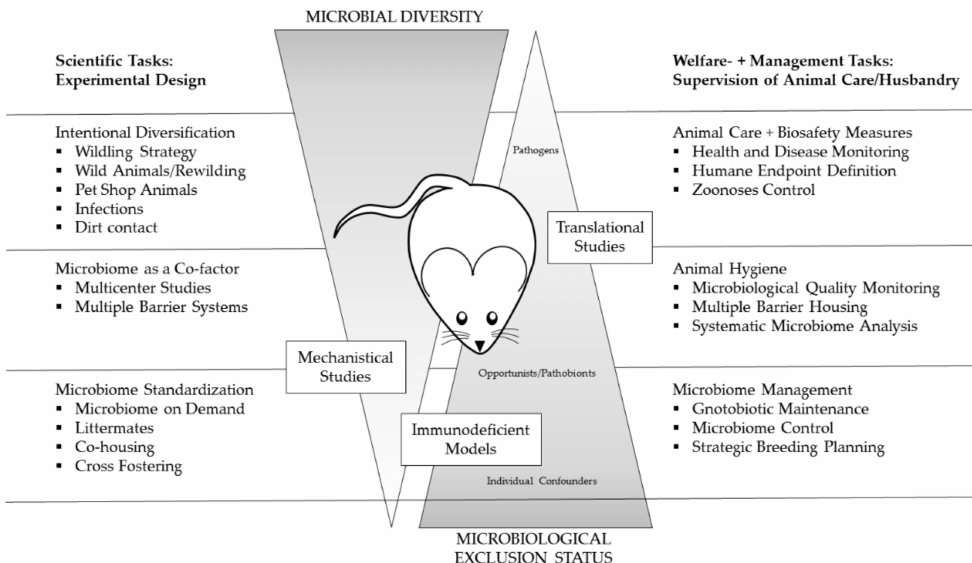
Figure 5. Dependencies of scientific strategies to cope with microbiome challenges, animal ´ s hygiene status as well as welfare and management tasks. The primarily scientific tasks regarding study design (depicted on the left-hand side) have enormous implications on the scope of hygienic management and health monitoring as well as on the veterinary care and colony management (depicted on the right hand side). Depending on the study planned, the microbial diversity and microbiological exclusion status have to match the requirements of the different animal models to ensure both scientific value and animal welfare, as implied by the 6Rs